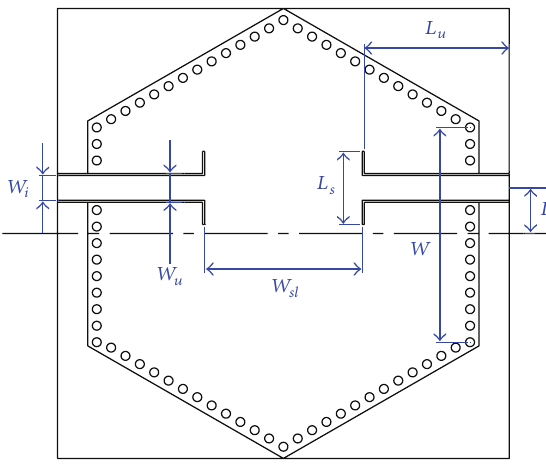
Figure 2: Geometric configuration of the proposed